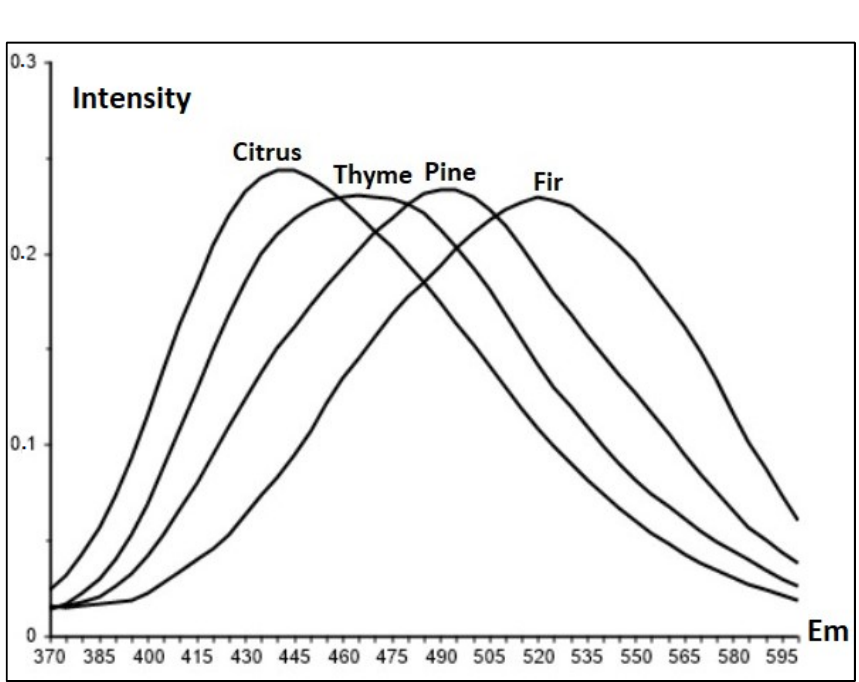
Figure 7. Emission spectrum at λ ex 360 nm.